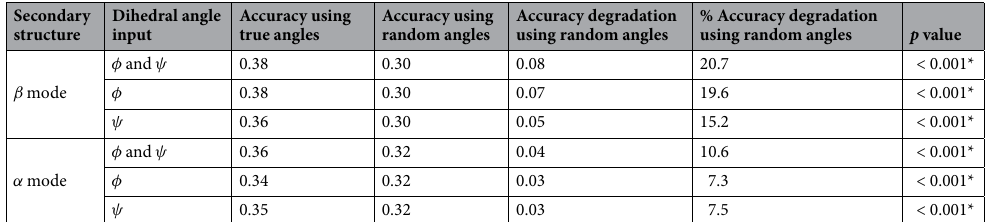
Table 2. Structural information improves the classification accuracy of synonymous codon identity. Significant results ( p value < 0.05 ) are indicated with